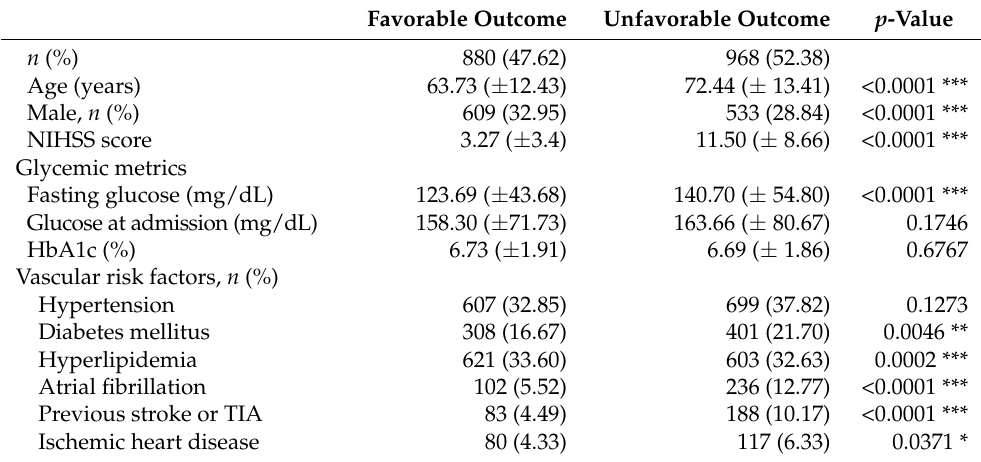
Table 1. Characteristics of patients with favorable and unfavorable 3-month outcomes after AIS.